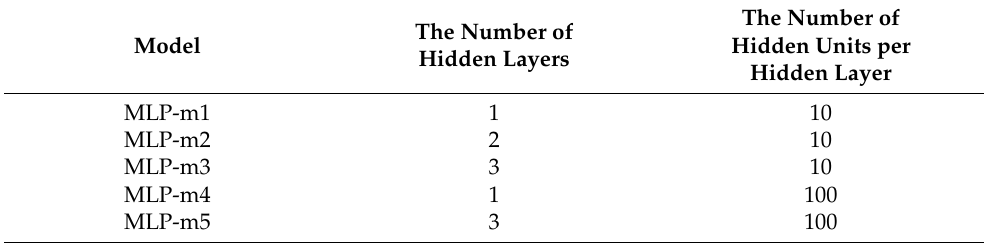
Table 4. Hidden layer and hidden unit settings for MLP-based anomaly detection models.